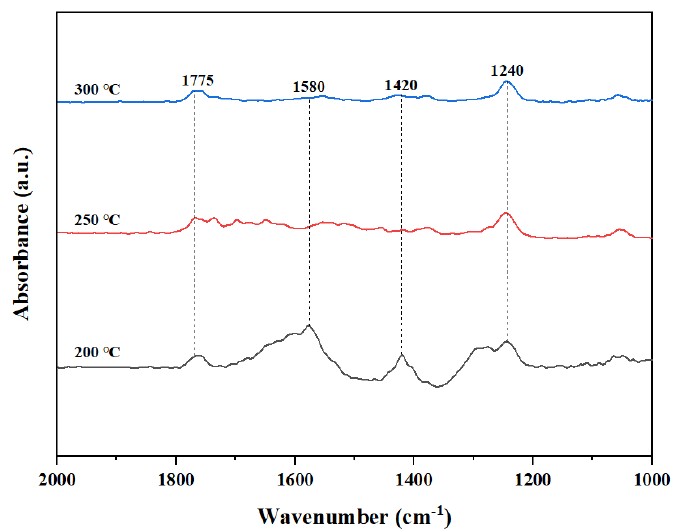
Figure 12. In situ DRIFTS spectra of the 5Ni/OMS-2 sample in a 2000 ppm ethyl acetate/O 2 /N 2 feed gas at different temperatures. gas at different temperatures.